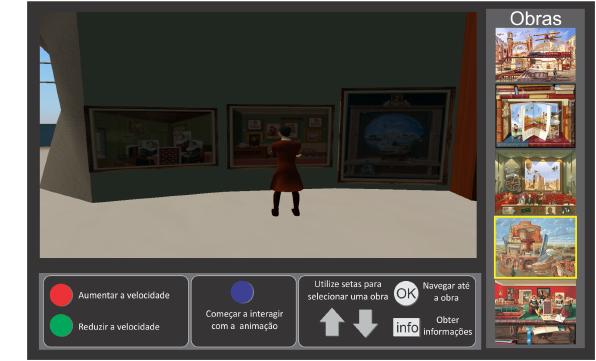
Figure 6. Navigation in the virtual environment